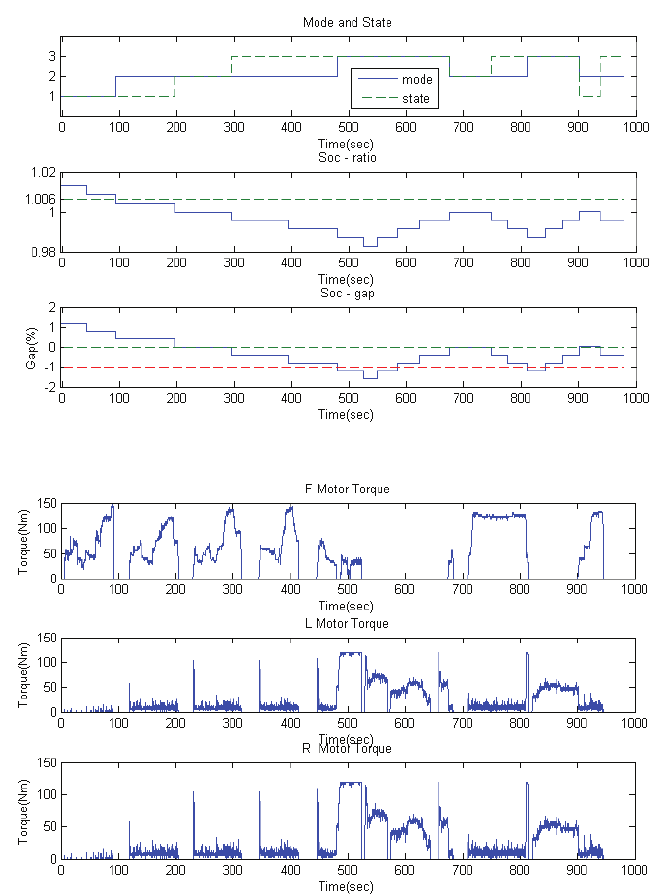
Figure 8. Histories of the mode (solid line), state (dashed line), state of charge (SOC) ratio, SOC gap and the torque distributions of the front, rear left, and rear right motors during torque and battery distribution process for the electric vehicle in the hardware-in-the-loop experiment.